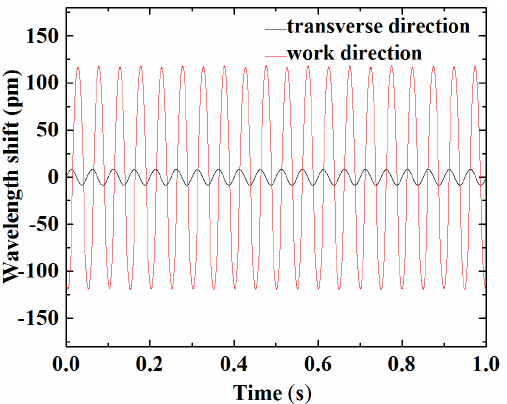
Figure 8. Cross-sensitivity of the sensor: response under excitation acceleration of 1 m/s 2 and frequency at 20 Hz.